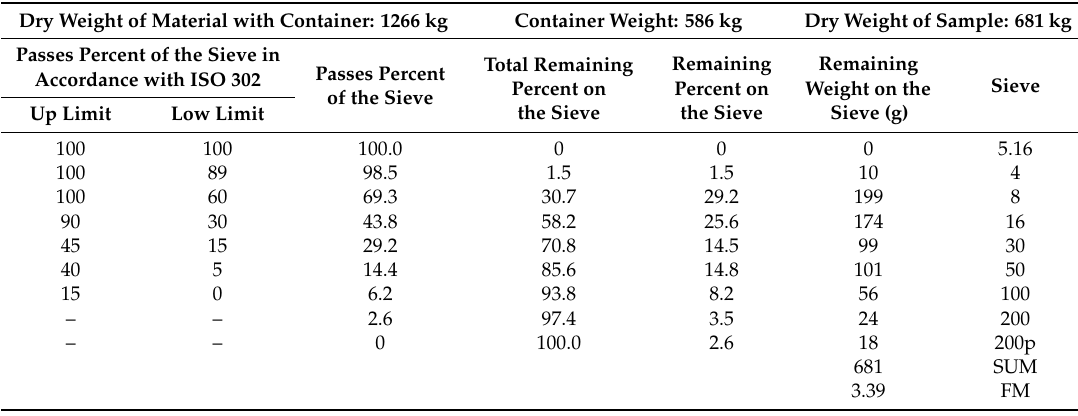
Table 9. Grading test specifications of silica sand.